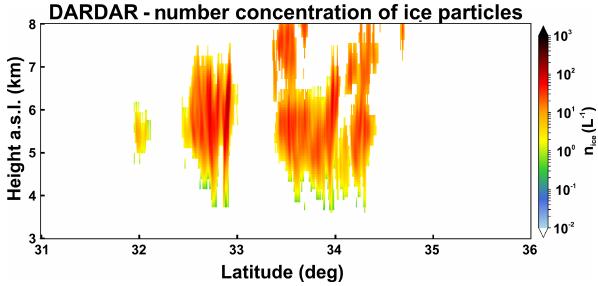
Figure 12. Spatial distribution of the DARDAR ice particle number concentrations at 11:01UTC on 21 April 2016.